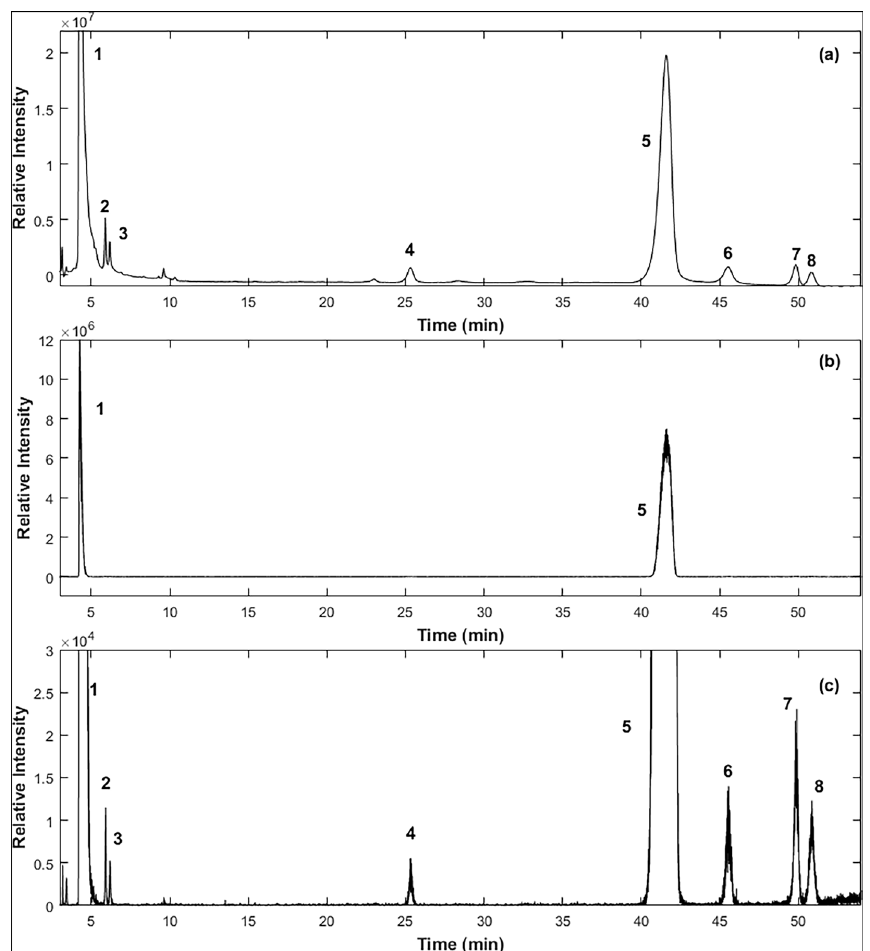
Fig. 2 a LC UV trace, b total ion chromatogram ( m/z 1400–1850) of heat-stressed dalbavancin (full scale), and c total ion chromatogram ( m/z − 1400–1850) of stressed dalbavancin (400 expanded view) in acetate buffered solution ×